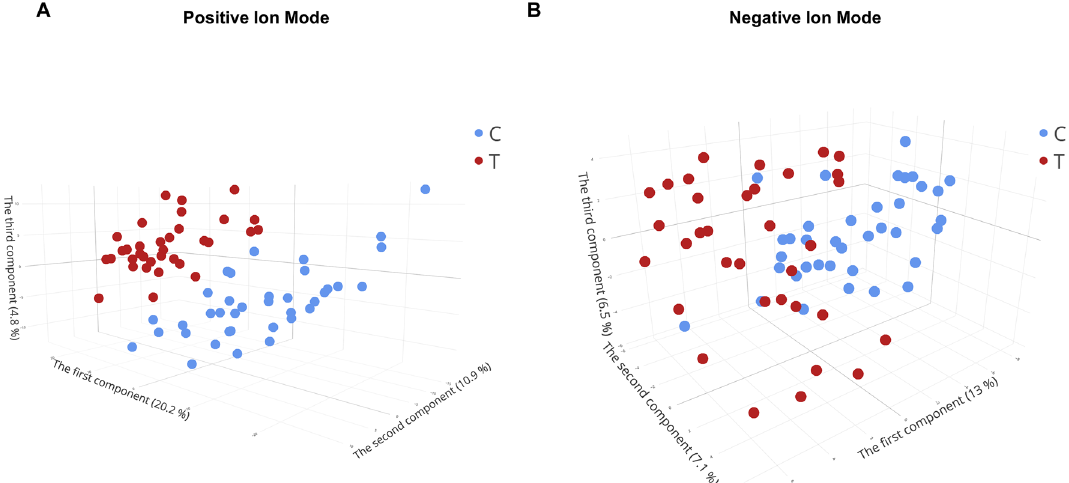
Figure 2. Partial least squares-discriminant analysis (PLS-DA) score plots of Tuberculosis patients and controls plasma lipidome. ( a ) PLS-DA 3D score plot of the two group in the positive ion mode. ( b ) PLS-DA 3D score plot of the two group in the negative ion mode. C control group, T Tuberculosis